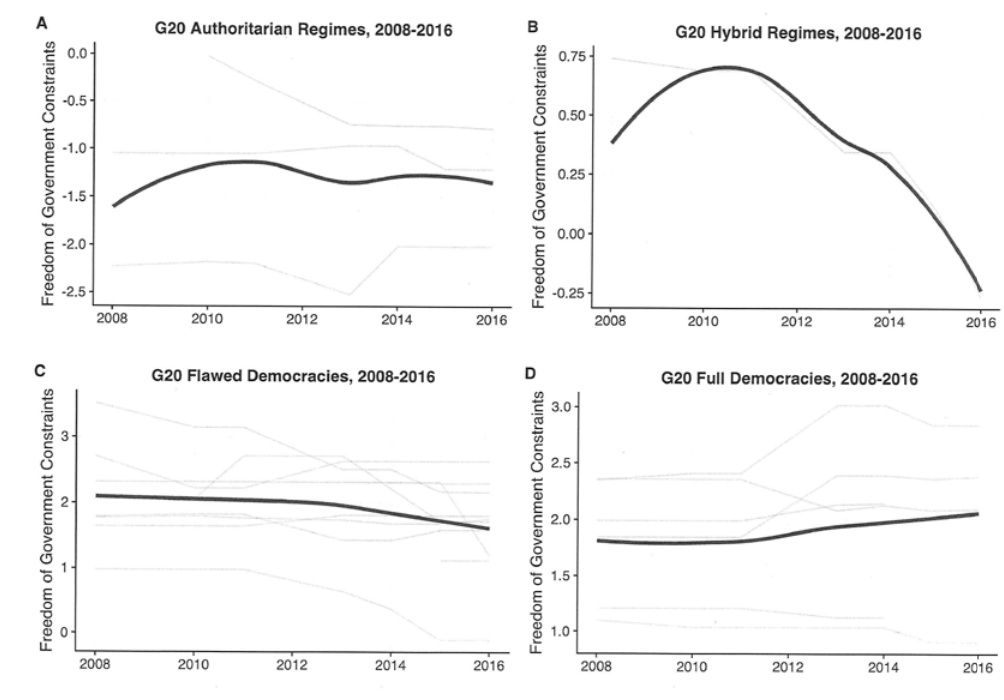
Figure 1 : Government Control over CSO Formation